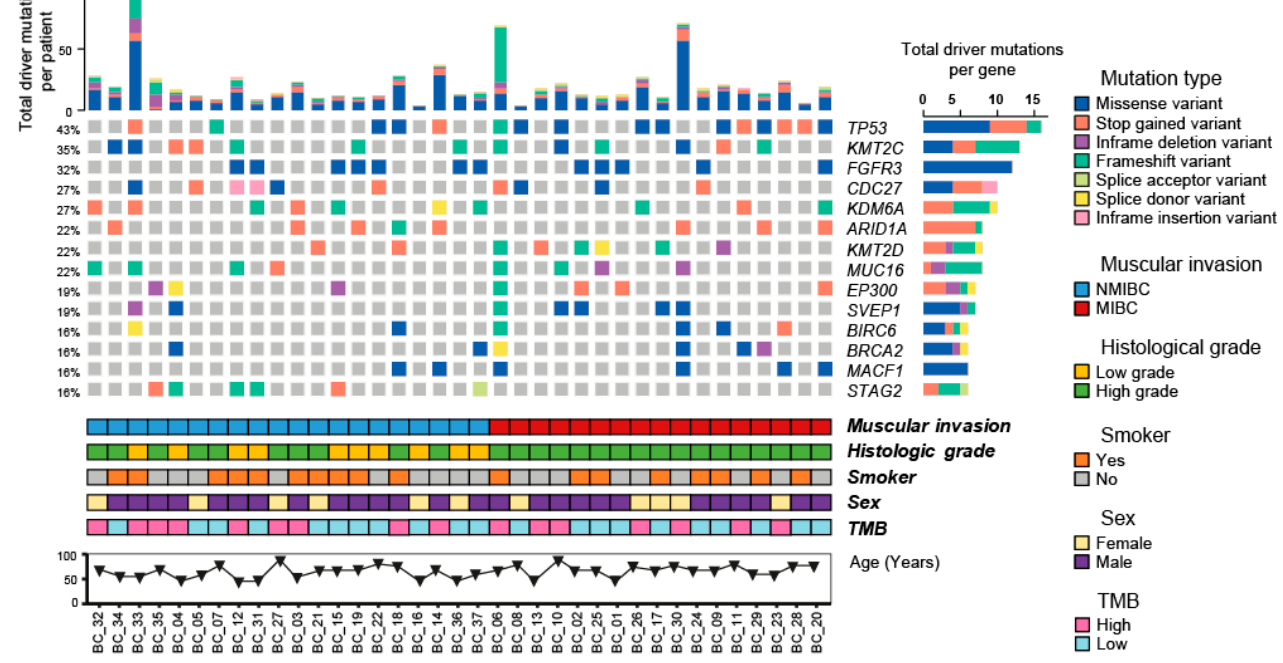
Figure 3. Driver somatic variants and clinical characteristics of patients with bladder cancer treated at INCan between 2012 and 2021 (N = 37). Oncoprint, sorted by muscular invasion (Non-muscle invasive bladder cancer [NMIBC], n = 20 and muscle invasive bladder cancer [MIBC], n = 17), depicting the genes affected by driver somatic variants (single nucleotide variations, small insertions, and small deletions) in 16% or more of the samples. The variants are represented according to the mutation type, each described on the right color panel. The upper bar plot represents the number of driver somatic variants per patient, and the right bar plot represents the number of driver somatic variants per gene. The lower paneer represents the muscular invasion, histologic grade, smoking history, and sex of the patients.